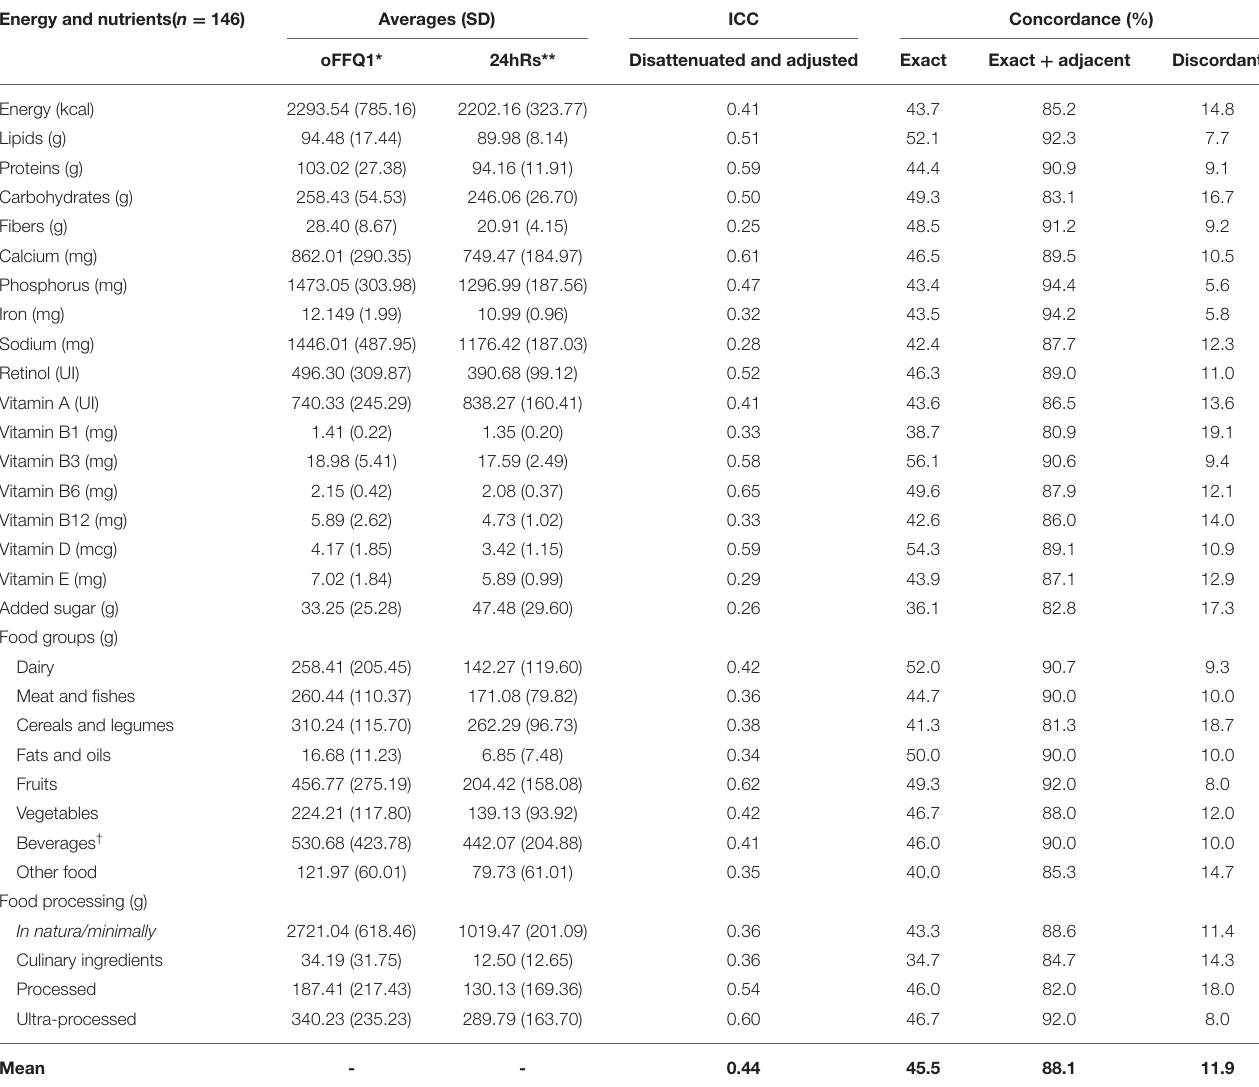
TABLE 2 | Mean and SD of daily consumption, intraclass correlation coefficient (ICC), and percentage (%) of concordance between the online food frequency questionnaire (oFFQ) and the 24-h dietary recalls (24hRs) ( n = 146 participants). Energy and nutrients( n =